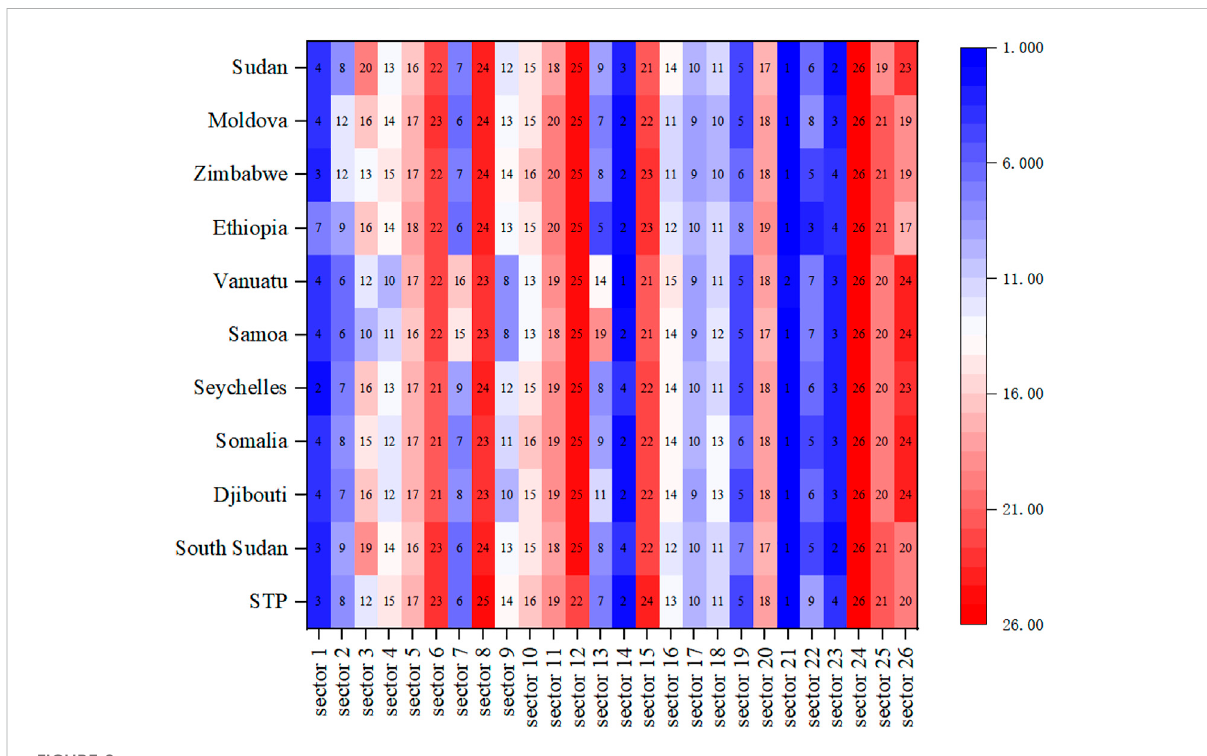
FIGURE 8 Biodiversity net exporting countries sectoral threat